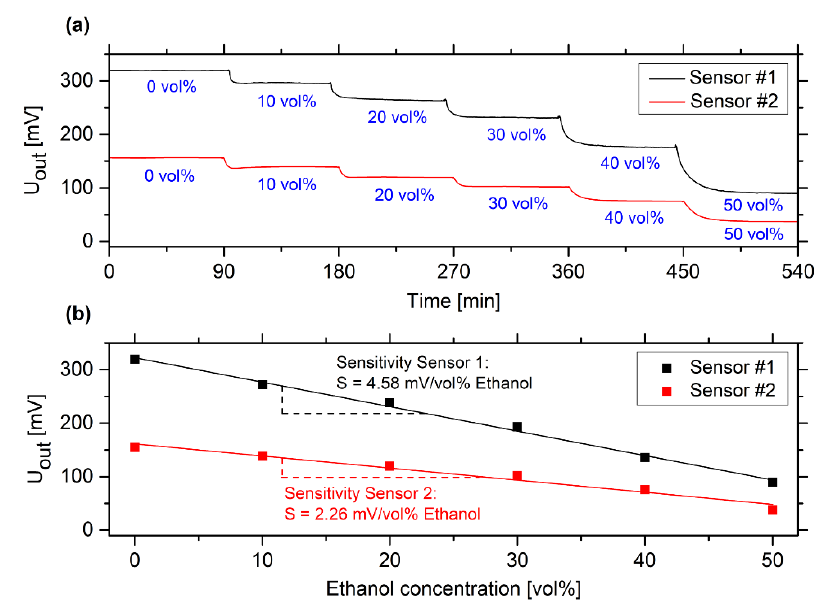
Figure 4. ( a ) Time-dependent change of the output voltage for two hydrogel-based ethanol sensors at different ethanol concentrations in a range from 0 to 50 vol% ethanol; and ( b ) the corresponding calibration curves of these sensors.